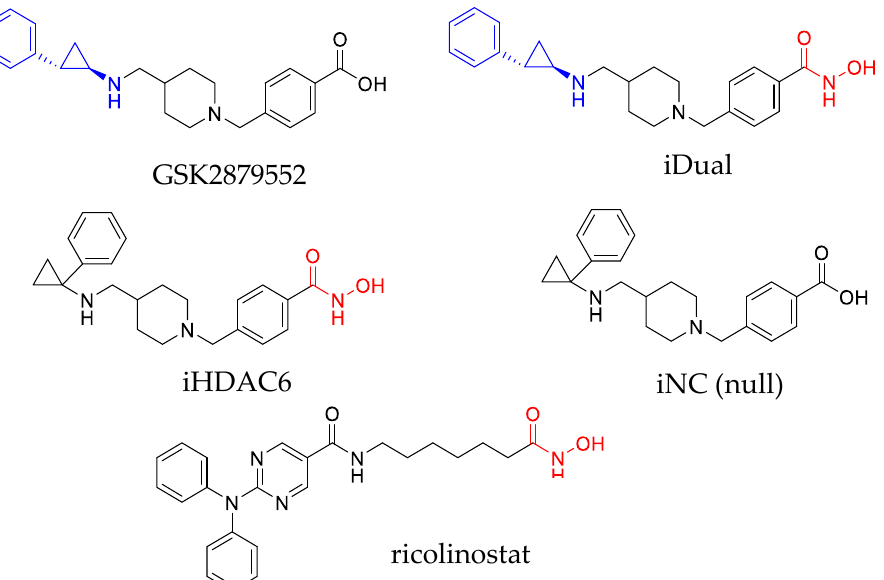
Figure 1. Structures of clinical candidates GSK2879552 and ricolinostat (targeting LSD1 and HDAC6, respectively), and the new analogues: dual inhibitor iDual, HDAC6 inhibitor (iHDAC6), and the negative control (iNC). The tranylcypromine and hydroxamic acid pharmacophores required for LSD1 and HDAC inhibition are highlighted, respectively, in blue and red.